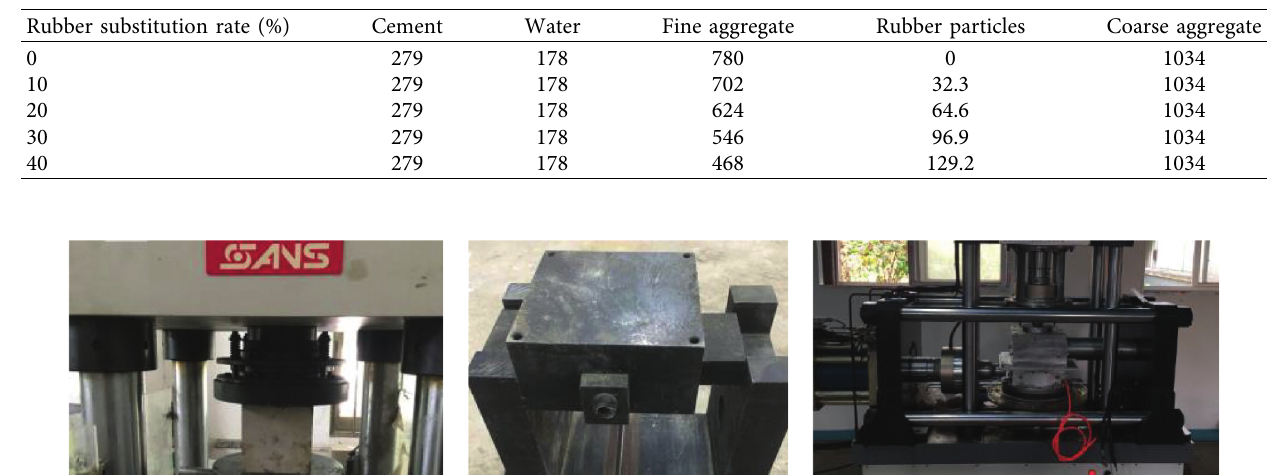
Figure 1: Rubber Table 1: The mix proportions of rubber concrete with different substitution rates (kg).